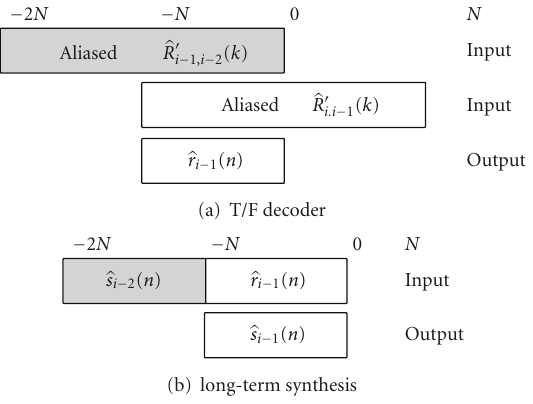
Figure 6: Decoder bu ff er of the proposed algorithm in each stage.